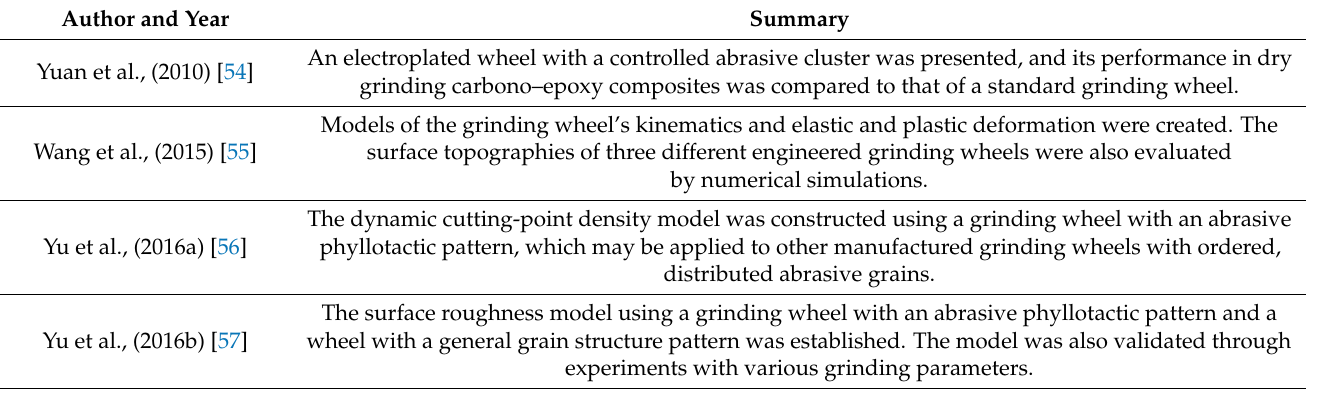
Table 3. Summary of publications on engineered